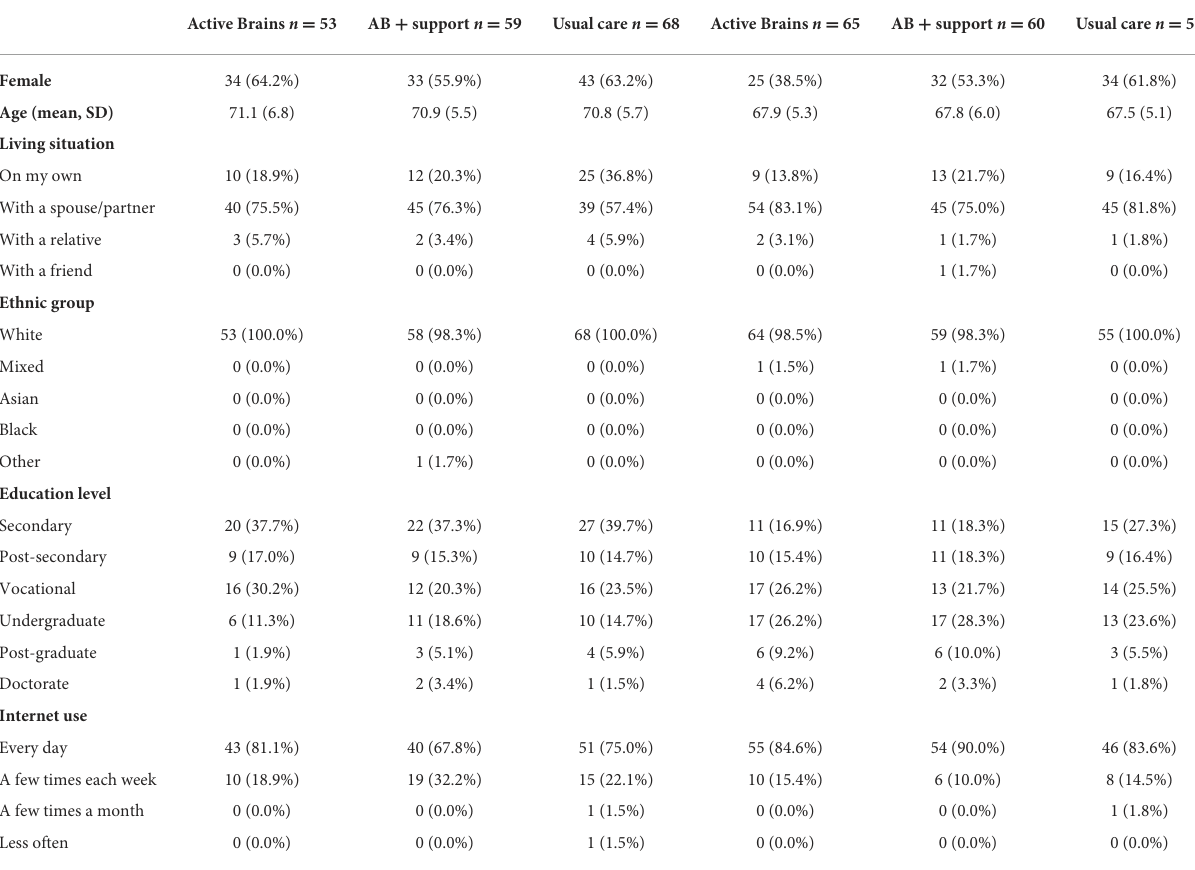
TABLE 1 Participant baseline characteristics in each trial. “Lower cognitive score”